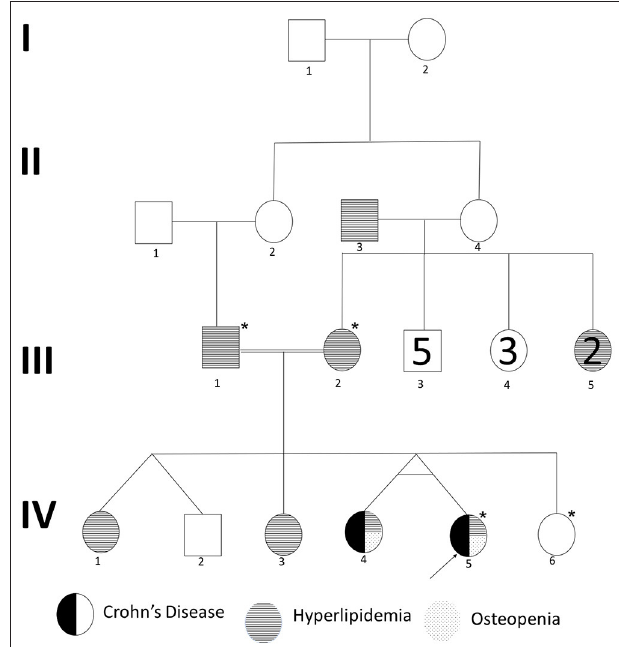
FIGURE 2 | Pedigree of a consanguineous family with an autosomal recessive mode of inheritance of EO-IBD. Exome sequenced individuals are indicated with an star (*) mark. Proband is indicated by an